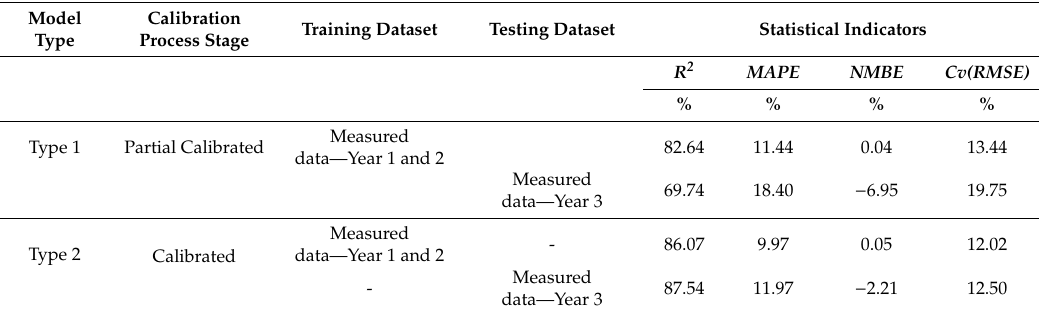
Table 7. Model training and testing on the operation phase data (calibrated models, a posteriori knowledge).